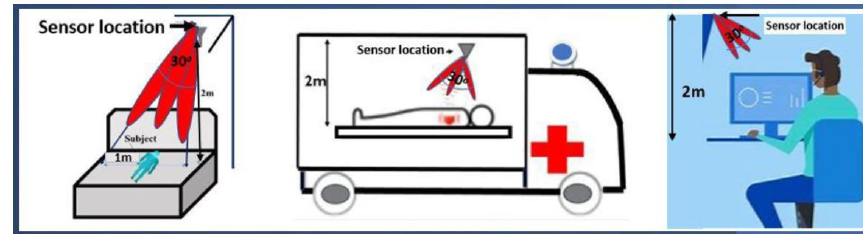
Figure 1. Examples of RVSM applications.